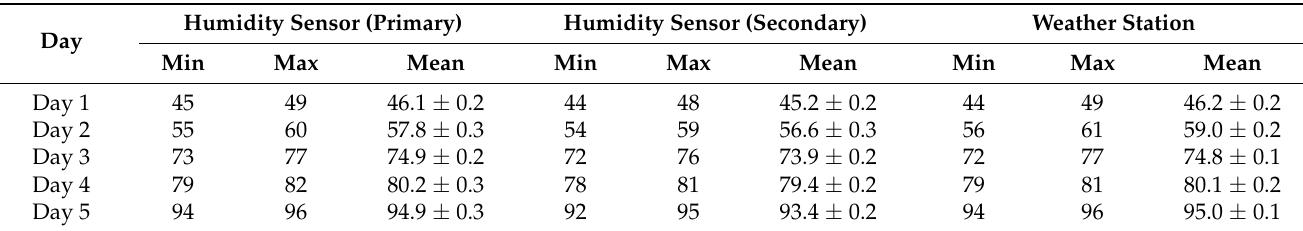
Table 4. Relative humidity (in %).